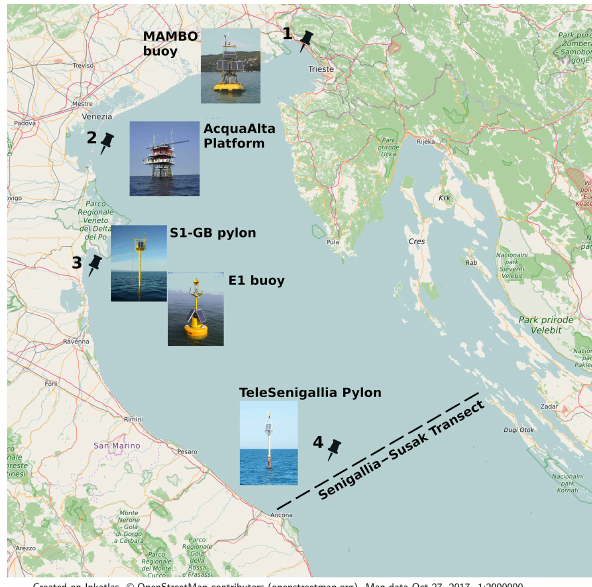
Figure 1. The LTER-Italy Northern Adriatic Sea parent site, with its four research sites: 1 – Gulf of Trieste; 2 – Gulf of Venice; 3 – Po Delta and Romagna Coast; 4 – Senigallia–Susak Transect. The fixed-point observatories at each research site are shown (see Ra- vaioli et al., 2016, for a full description). Base map credits: © Open- StreetMap contributors 2019. Distributed under a CC-BY-SA Li-